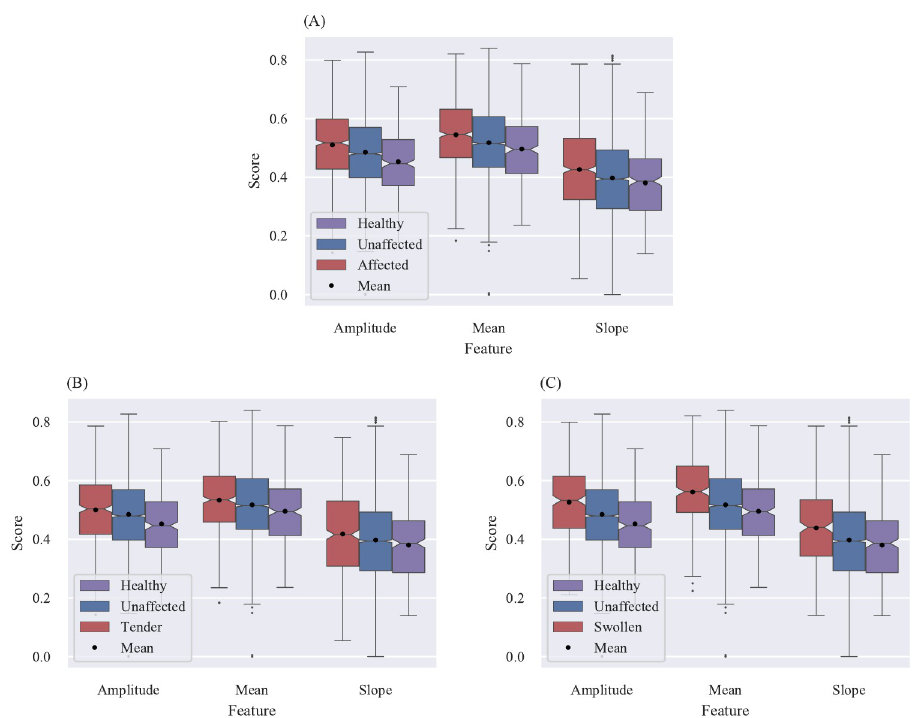
Fig 6. Comparison between the calculated scores for unaffected and affected labelled joints based on clinical labelling (k = 7). (A) Comparison between affected and unaffected labelled joints (sub-category: affected, k = 7). (B) Comparison between tender and unaffected labelled joints (sub-category: tender, k = 7). (C) Comparison between swollen and unaffected labelled joints (sub-category: swollen, k = 7).